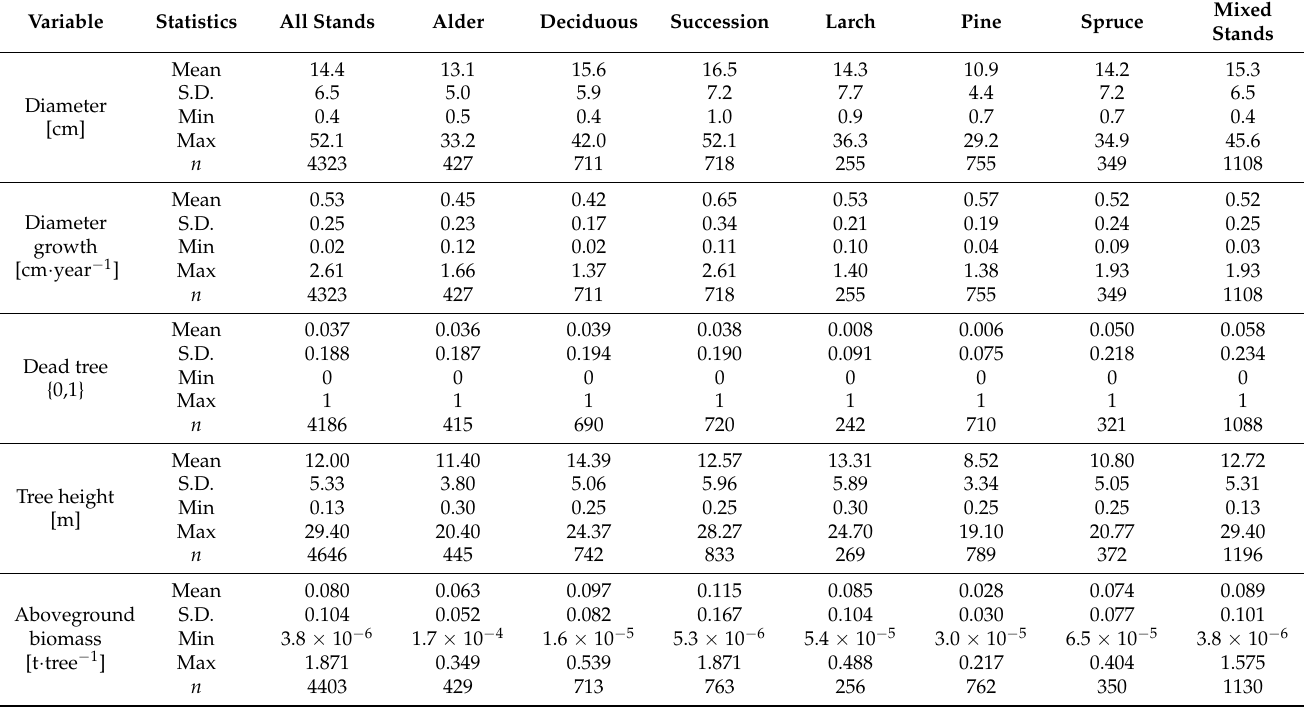
Table A6. Descriptive statistics of tree characteristics for individual tree